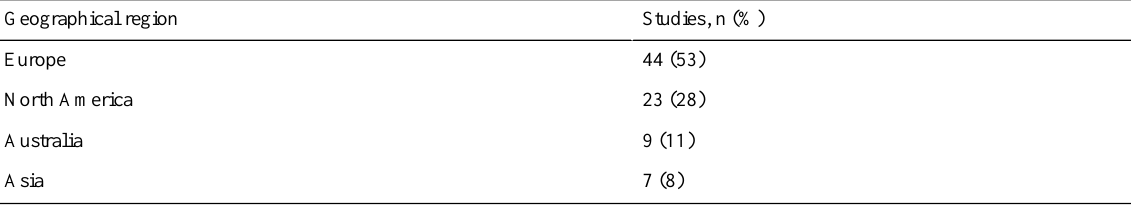
Table 3. Trials by geographical region